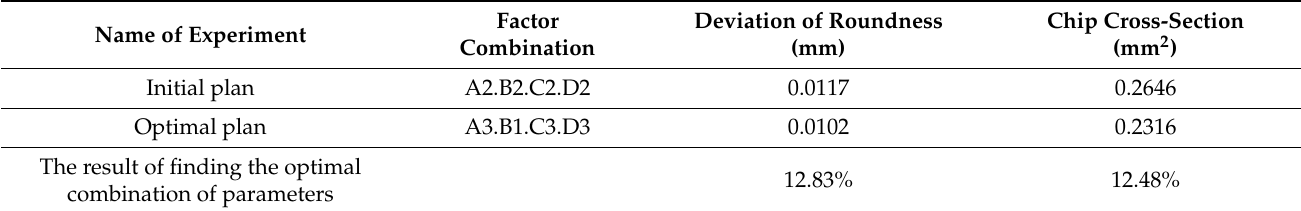
Table 10. Comparison of results between initial level and optimal levels of input factors (values from 5 repeated trials). Name of